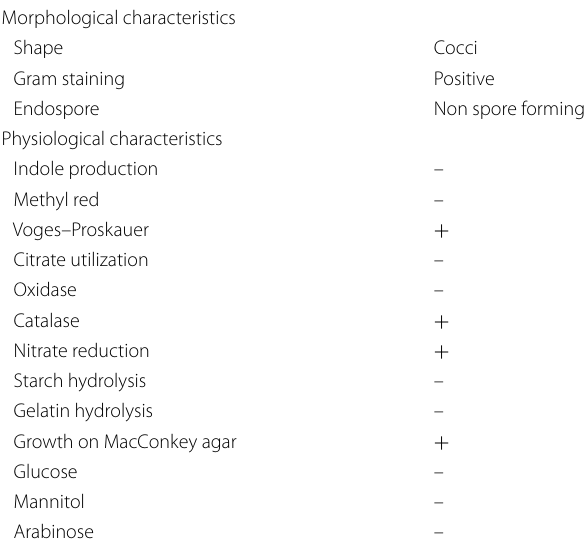
Table 1 Morphological and physiological characteristics of isolate Arthrobacter sp.